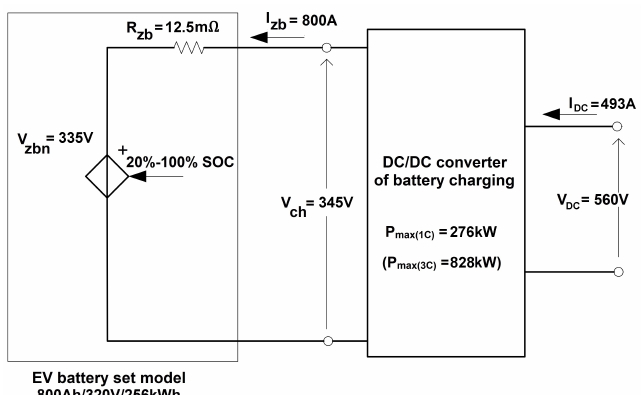
Figure 1. Model of 100cx8ch battery set made of Li-ion cells LPF100AHA-800 Ah/320 V/256 kWh with